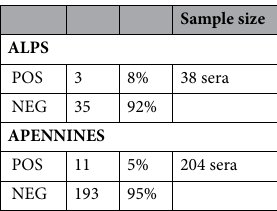
Table 2. Serosurvey of wild animals from mountain regions. The table shows origin and number of tested sera and seroprevalence of swine feral